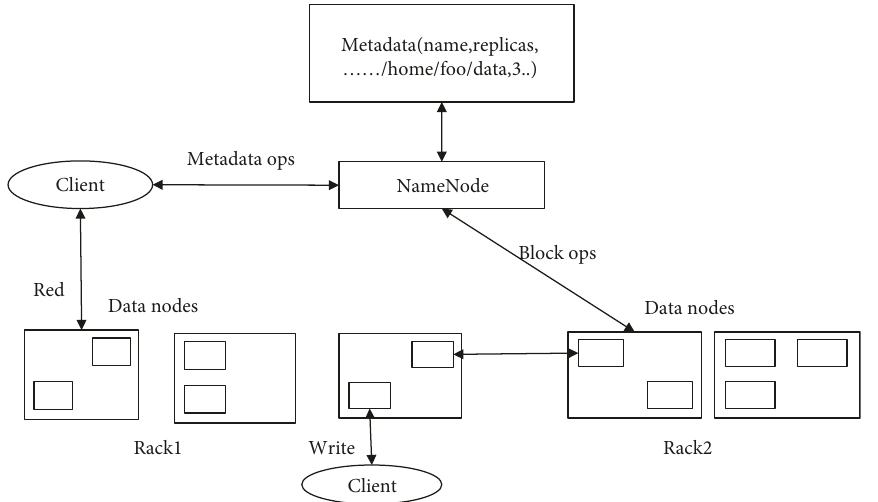
Figure 1: Principle of HDFS